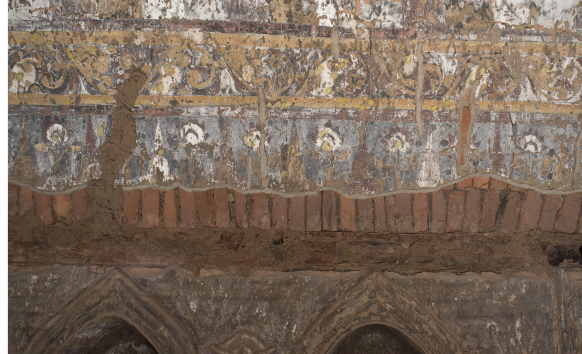
Figure 2. Interior wall painting scheme of